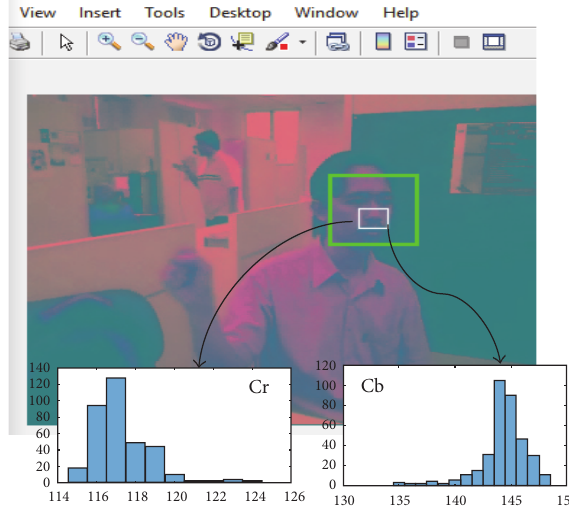
Figure 2: Using detected nose region of user in Y CbCr to train skin threshold factors